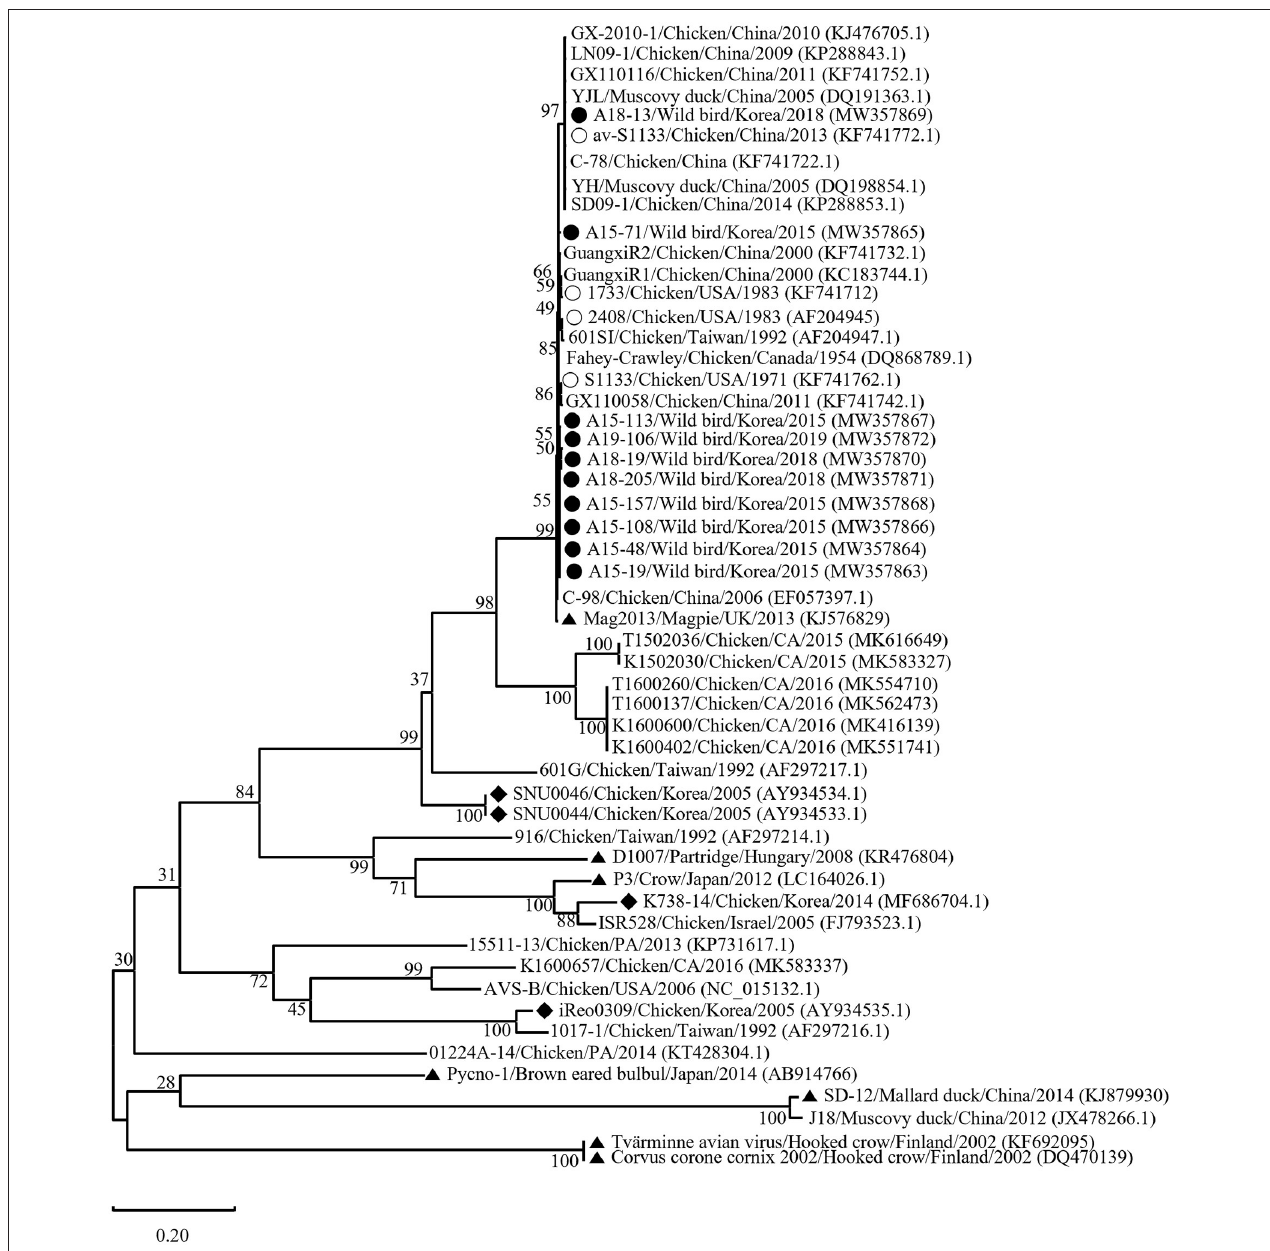
FIGURE 2 | Maximum likelihood phylogenetic tree for the σ C-encoding gene based on nucleotide sequences (981 nt). Maximum likelihood phylogenetic analyses were conducted using MEGA-X software with the Kimura 2-parameter model and 1,000 bootstrap replicates. The 43 reference sequences were obtained from GenBank. The black circle (•) indicates our isolates, while the white circle ( ◦ ) indicates the vaccine isolates. Additionally, the black diamond ( (cid:7) ) indicates field isolates in Korea, and the black triangle ( N ) indicates previously isolated wild bird isolates. Each sequence on the tree is identified by the isolate name, host, country of origin, year of isolation, and GenBank accession